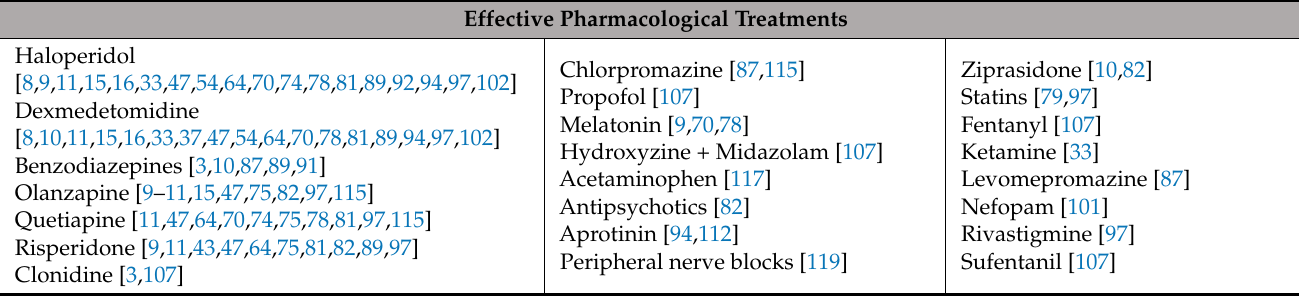
Table 4. Effective pharmacological methods for the treatment of postoperative